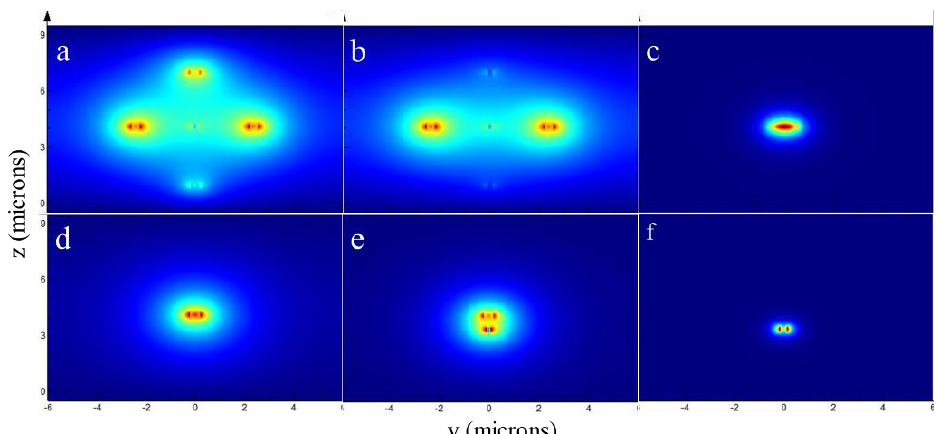
Figure 5. Simulated modal field evolution along the coupler: ( a ) near the edge coupler facet; ( b ) upper (or lower) Si 3 N 4 waveguide termination point; ( c ) curved waveguide termination point; ( d ) 36 µ m before Si 3 N 4 first SSC termination point; ( e ) Si 3 N 4 first SSC termination point; ( f ) highly confined mode in the silicon wire waveguide. The simulated mode is quasi-TE mode in 1550 nm.